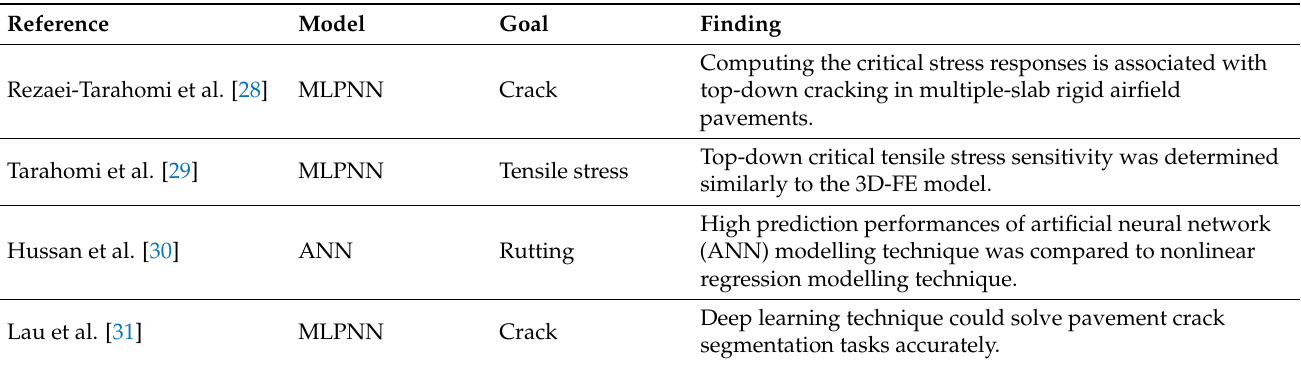
Table 3. Comparison of models and goals in asphalt mixture